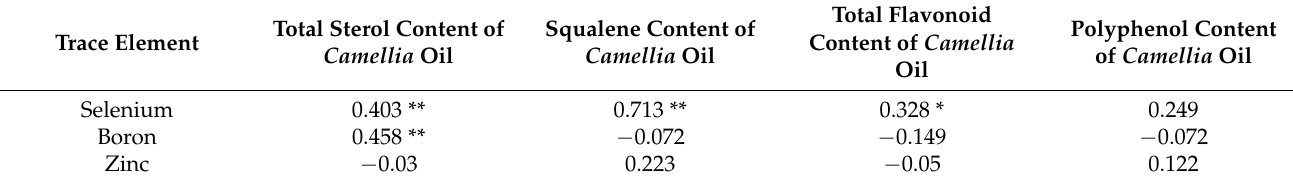
Table 4. Correlation analysis between trace elements and components in Camellia oleifera